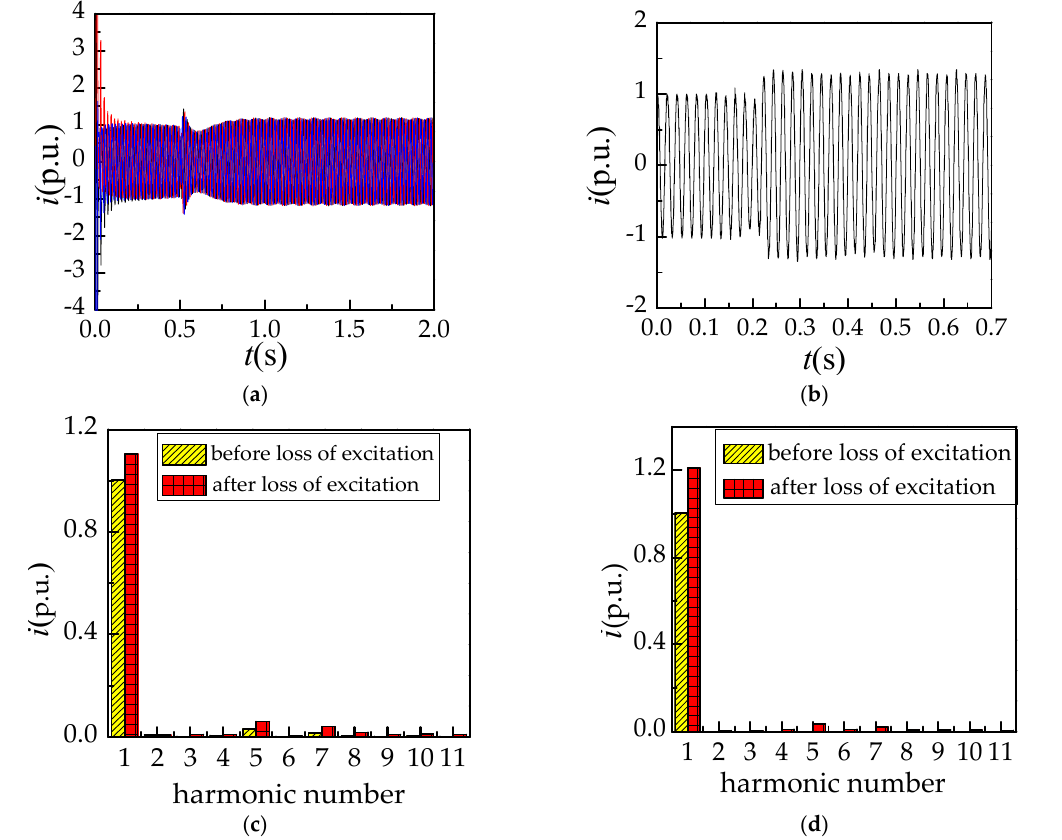
Figure 7. The stator current and harmonic analysis under the three phase short-circuit loss of excitation: ( a ) Simulation results; ( b ) test results; ( c ) simulation results; ( d ) test results.